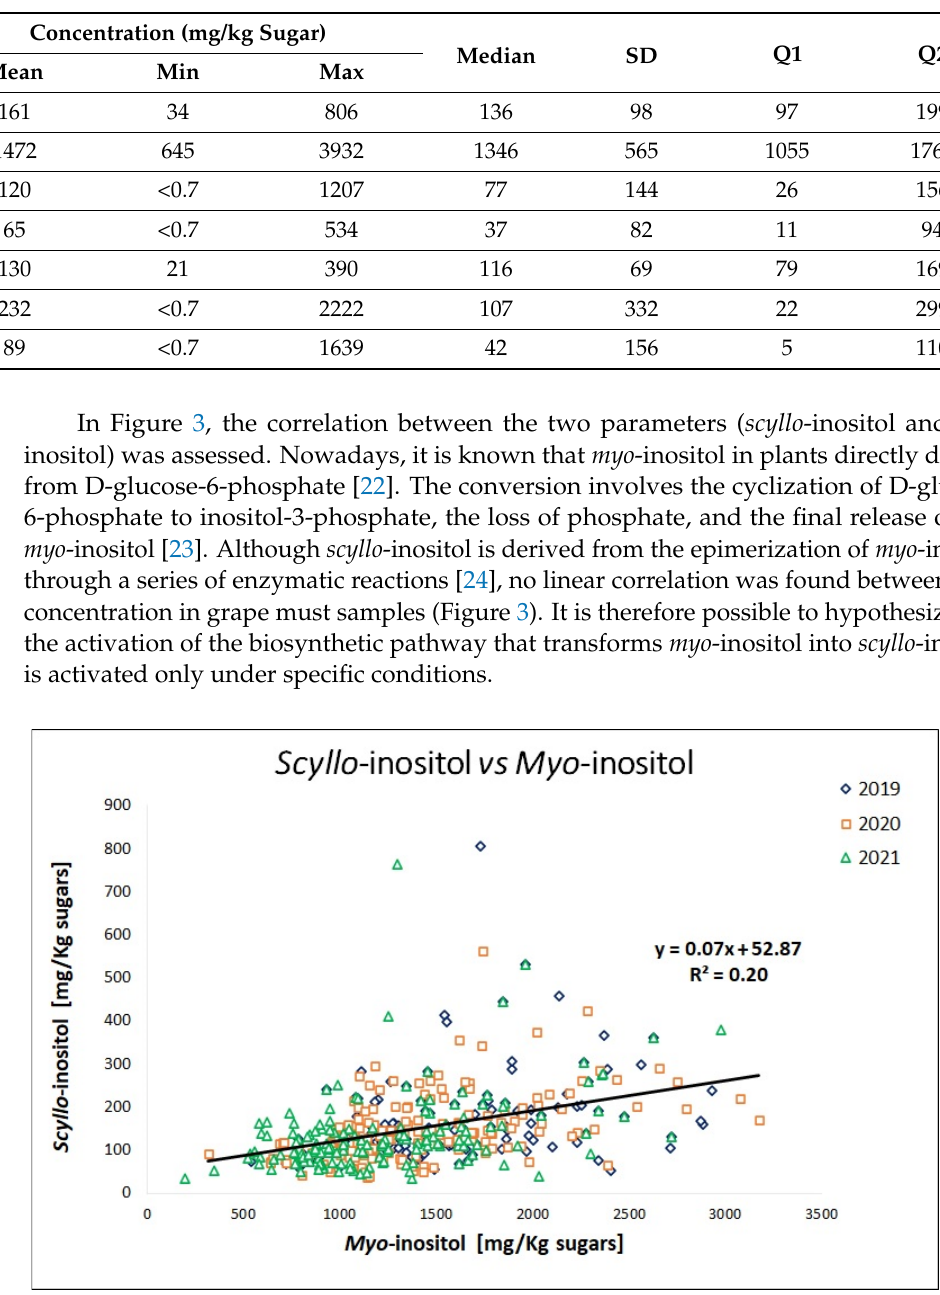
Table 3. Concentration range (mean value, max value, and min value), median, standard deviation (SD), first quartile (Q1), and third quartile (Q3) of the target compounds detected in natural grape must samples ( n = 450).